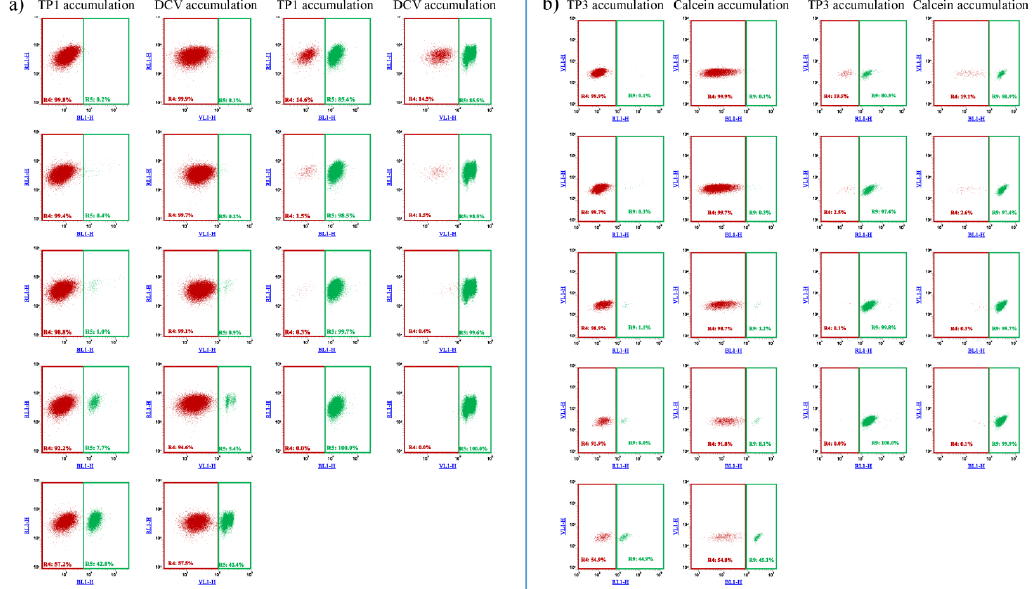
Figure 3. Flow cytometry detection of TP1 ( a ) or TP3 ( b ) accumulation in human PLB-985 cells: recognition and separation of control PLB-985 cells and PLB-985 cells expressing the ABCB1 transporter, respectively. Comparison to cell recognition by DCV accumulation. Control PLB-985 cells (green) and PLB-985 cells expressing wild-type ABCB1 (red) were mixed in various ratios, from 0.2% to 99.8%, respectively. TP1 accumulation was measured after incubation with 500 nM TP1 for 24 h at 37 °C. DCV accumulation was measured after the addition of 1 µM DCV (incubation for 1 h, at 37 °C). TP3 accumulation was measured after incubation with 200 nM TP1 for 24 h at 37 °C. Calcein accumulation was measured after the addition of 250 nM Calcein AM (incubation for 15 min at 37 °C).